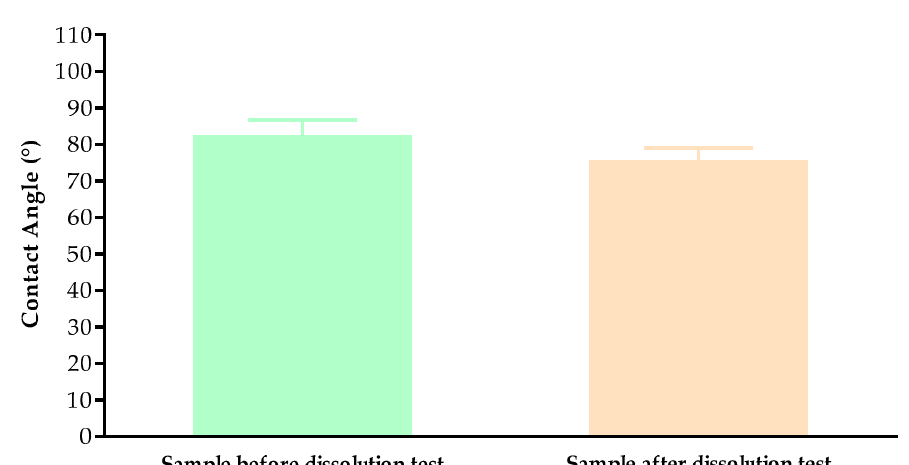
Figure 6. Contact angle values of the printed TPU samples before the dissolution test and the filled samples after the dissolution test. Data are expressed as means ± SD. Experiments were performed sixteen times, n = 16.